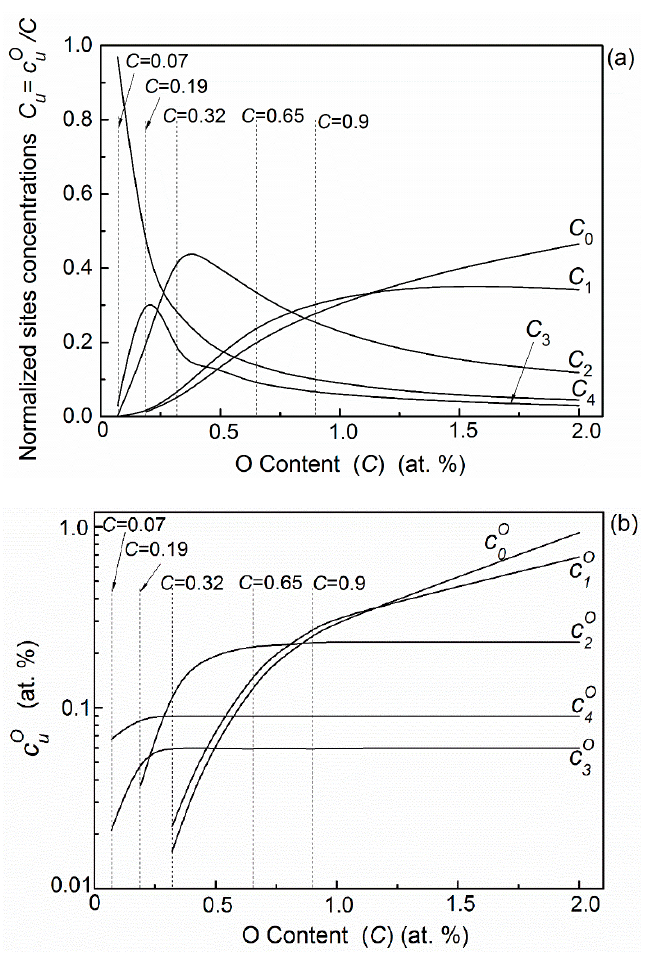
Figure 6. The distribution of oxygen atoms in Nb–0.5V (at. %) alloys with different oxygen content ( 6 ∑ c O u ): ( a ) normalized distributions C u ( C u = c O u / C ); ( b ) absolute distribution c O u